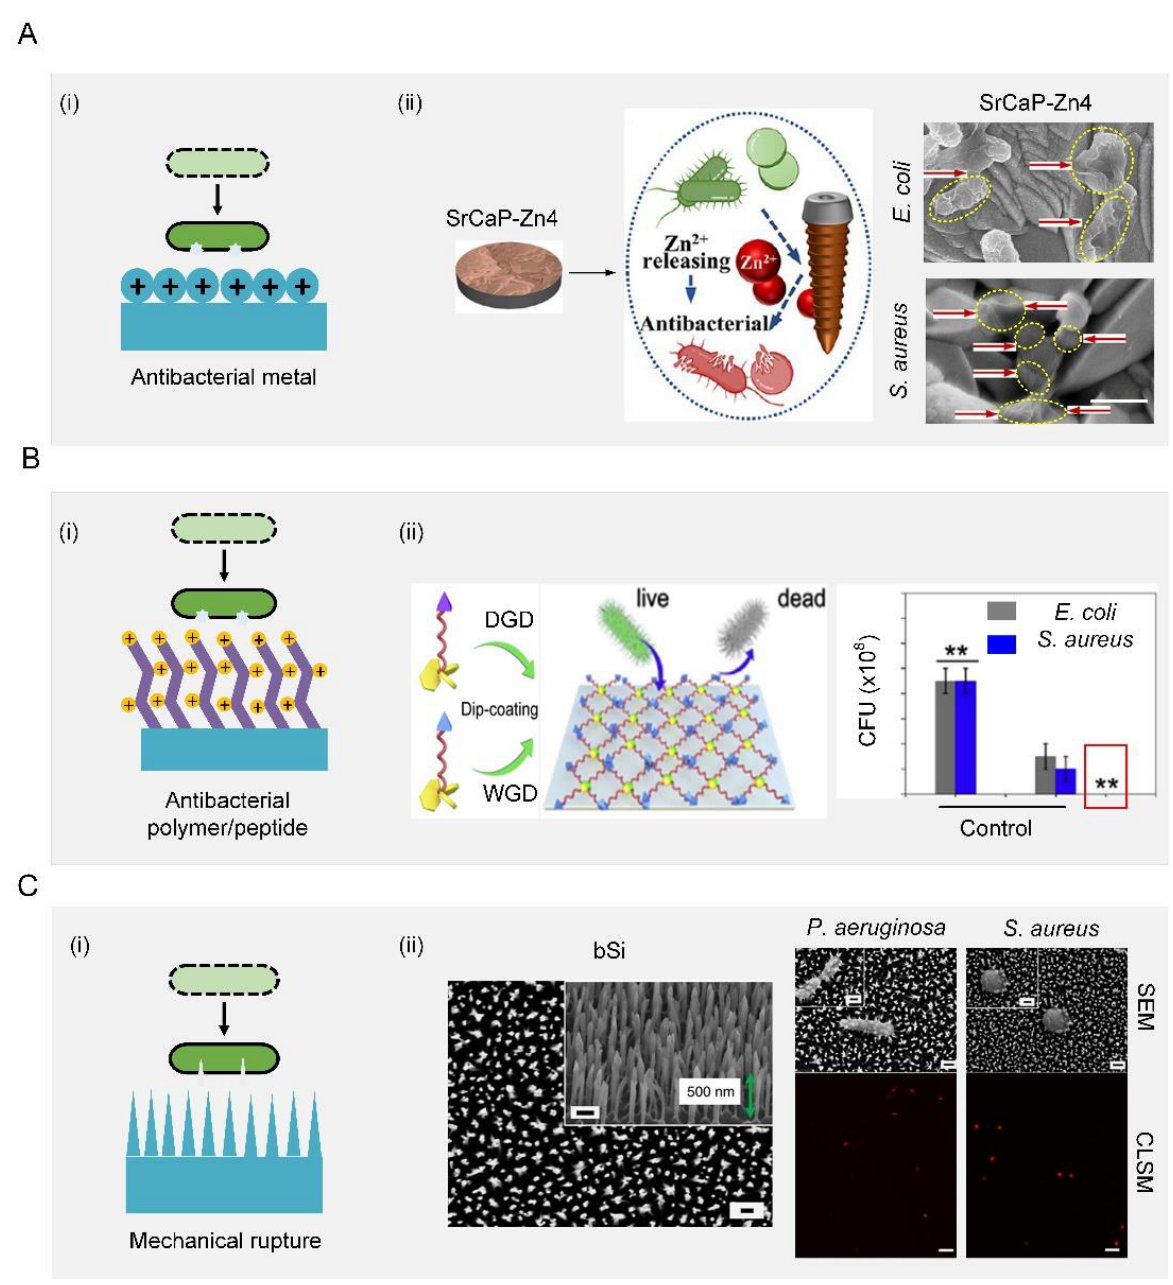
Figure 5. Contact-killing surfaces. ( A ) Schematic diagram of an antibacterial metal surface (i) Schematic illustration of antibacterial metal for synergistic photothermal/pharmacological antibacterial therapy (ii). Scale bar: 500 nm. Reproduced with permission [105]. 2021, Elsevier. ( B ) Schematic di- agram of antibacterial polymer/peptide surface (i) schematic illustration of antibacterial polypeptide WRWRWR-G 4 -(dihydroxyphenylalanine) 4 and their application for the surface functionalization of medical implants (ii). Reproduced with permission [118]. 2019, Elsevier. ( C ) Schematic diagram of mechanical rupture surface (i) SEM image of the upper surface of black silicon. Scale bars: 200 nm. SEM images of P. aeruginosa and S. aureus were significantly disrupted through interaction with black silicon. Scale bars, 200 nm. CLSM images confirmed that disruption by black silicon was lethal